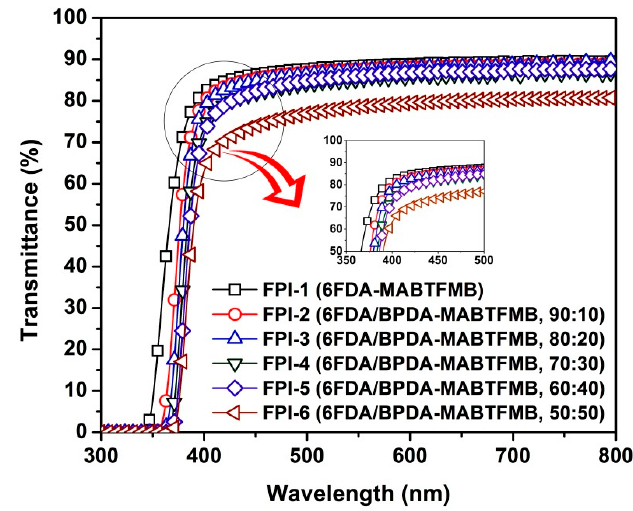
Figure 5. UV-Vis spectra of FPI films. Table 3. Optical properties of the FPI films.